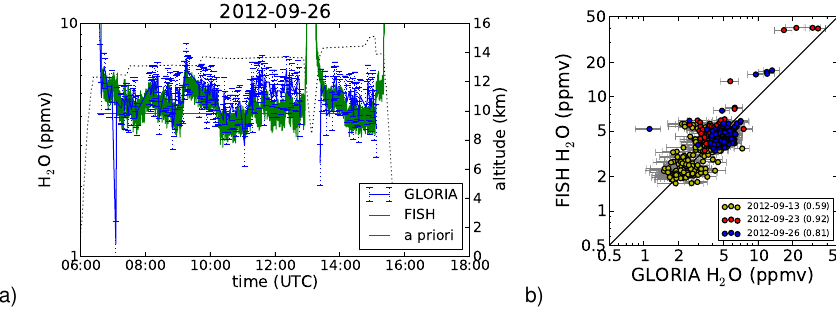
Figure 7. Comparison of retrieved temperature 125 m below flight level and temperature measured by the HALO BAHAMAS system. The error bars of retrieved values use the total error (accuracy plus precision). (a) shows the values over time for the flight of 26 September 2012; in addition the a priori information employed with assumed uncertainty and flight altitude is given. (b) shows the correlation for the three currently processed flights; the Pearson correlation coefficient for the flights is given in the legend. See also Table 5.